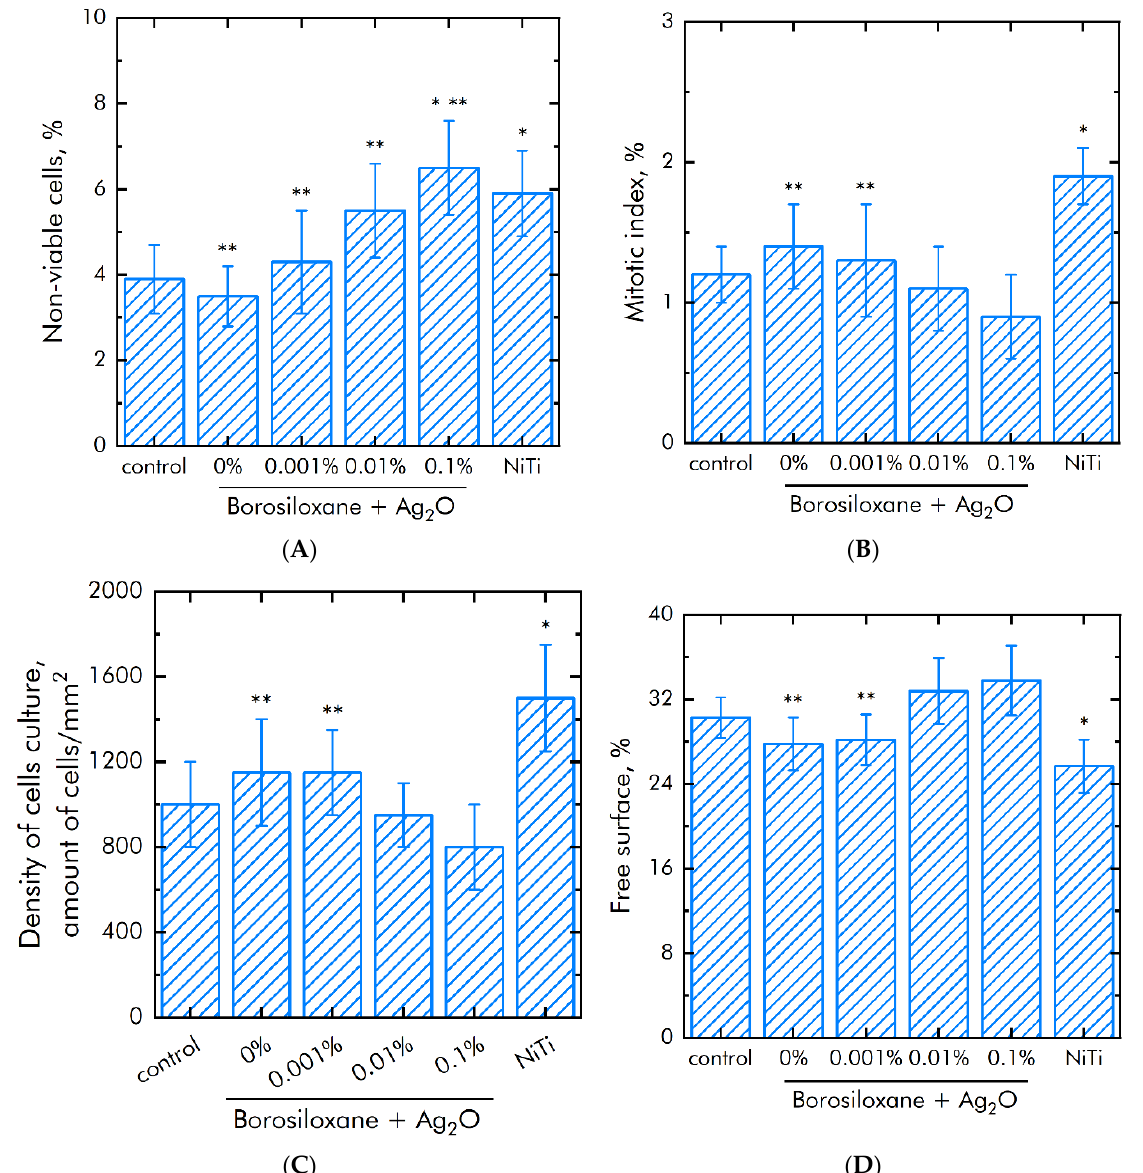
Figure 11. Effect of a BS and composition Ag 2 O NPs·BS the of cell line SH-SY5Y proliferation, adhesion and survival. ( A ) — Survival of cells. ( B ) — Mitotic indexes. ( C ) — Density of cells monolayer. ( D ) — Space of surface without cells. * — p < 0.05 vs. control, ** — p < 0.05 vs, NiTi. Data are shown as means ± SEMs.